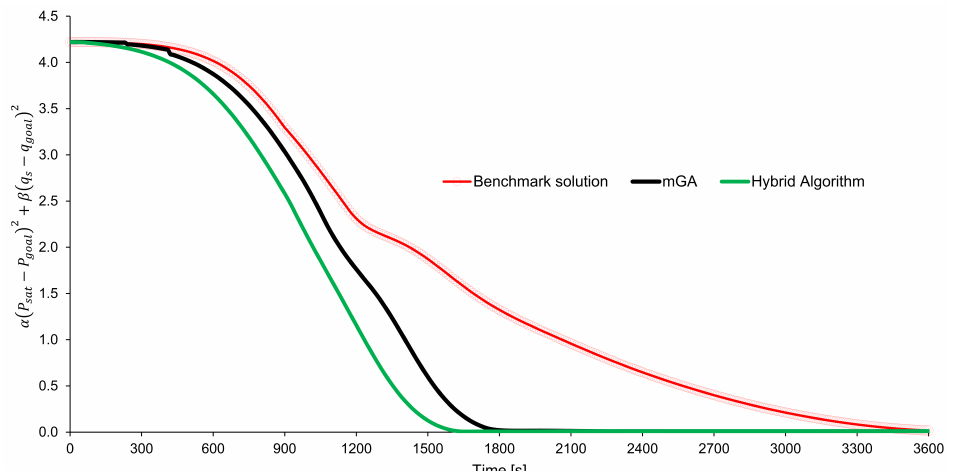
Figure 12. Change of the distance to the goal state over time over time for the benchmark solution (red line), the micro genetic algorithm (black line) and the proposed metaheuristic hybrid algorithm (green line).